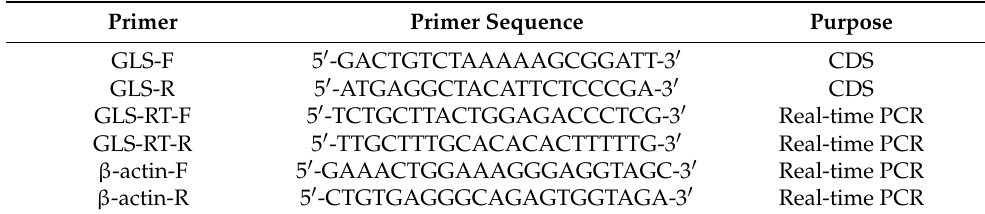
Table 5. Primers used for gls1 cloning and quantitative real-time